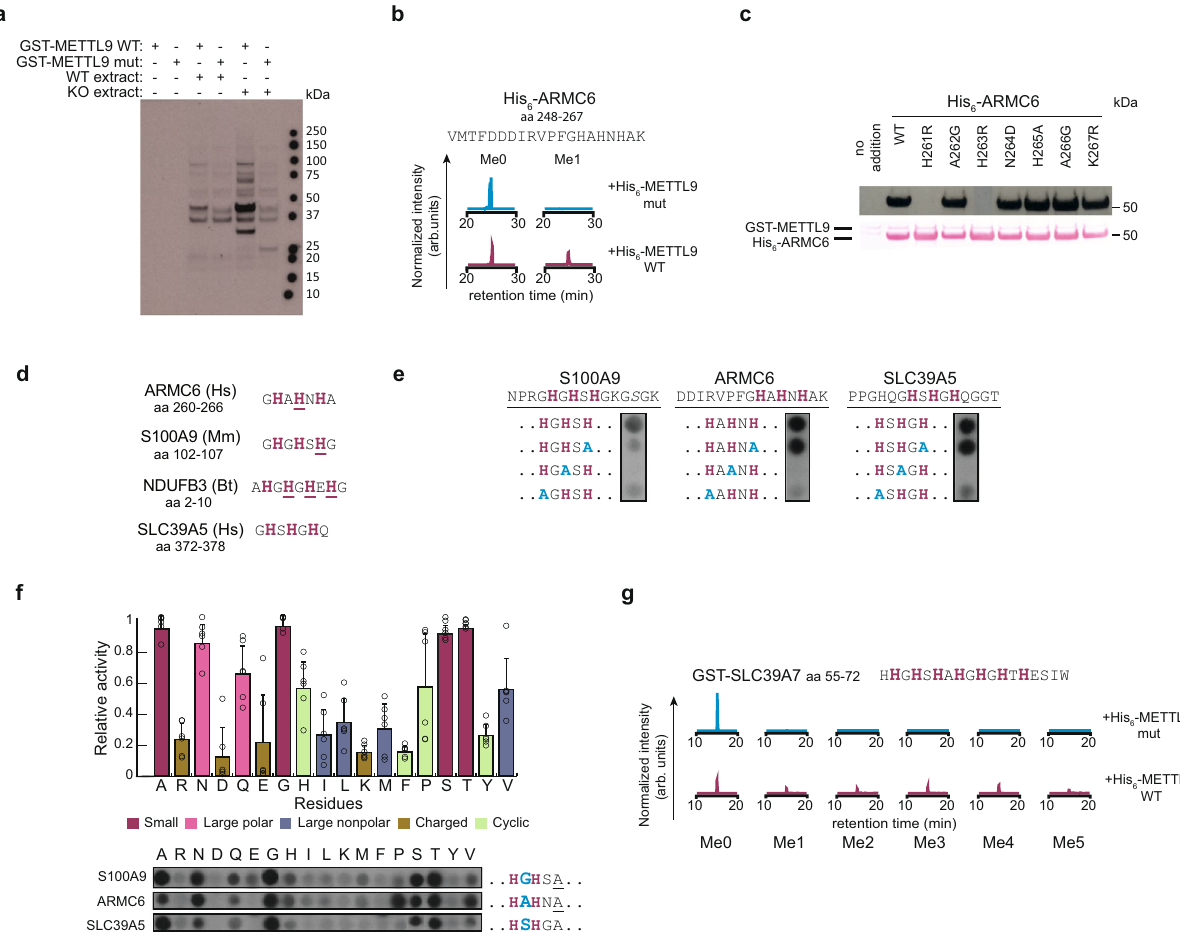
Fig. 1 METTL9 is a protein histidine methyltransferase that methylates the ANGST HxH motif. a Fluorography showing MTase activity, using [ 3 H] AdoMet, of recombinant wild-type (WT) GST-hMETTL9 on proteins in the membrane fraction from WT and METTL9 KO HAP1 cells (METTL9 mut: inactive mutant E147A). The data are representative of three independent experiments. b Enzymatically active METTL9 methylates ARMC6. Recombinant His 6 -ARMC6 was treated with His 6 -hMETTL9 in the presence of AdoMet in vitro, then digested with trypsin, and the resulting peptides analyzed by LC- MS. Normalized extracted ion chromatograms (XICs) corresponding to the monomethylated (Me1) and unmethylated (Me0) forms of the peptide ARMC6 248-267 are shown (full XICs are shown in Supplementary Fig. 3). c Fluorography showing in vitro activity of GST-METTL9 on WT and mutated recombinant His 6 -ARMC6 (top). Ponceau S-stained membrane as loading control (bottom). The data are representative of three independent experiments. d HxHxH-containing sequences from human (Hs) ARMC6 and SLC39A5, bovine (Bt) NDUFB3, and mouse (Mm) S100A9 proteins with known methylated His underlined. e Activity of His 6 -hMETTL9, using [ 3 H]AdoMet, on a peptide array containing WT and His-to-Ala substituted (blue) peptides derived